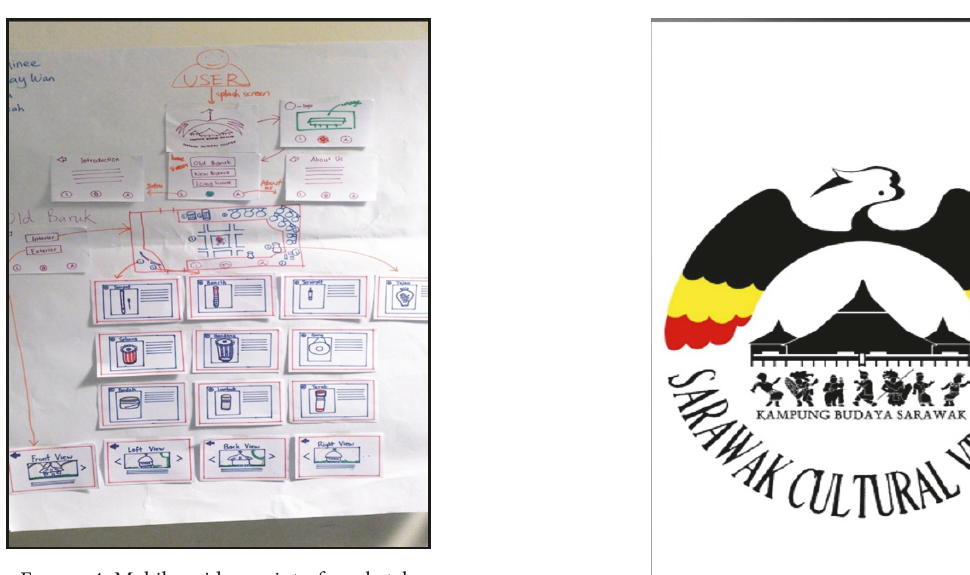
Figure 4: Mobile guide app interface sketch.